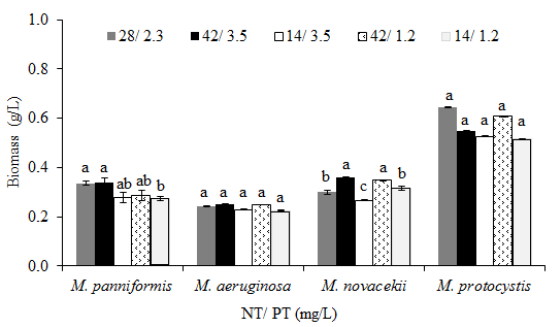
Figure 4 - Maximum biomass and standard deviations (g/L) for the cyanobacteria species cultivated at distinct nitrogen and phosphorous concentrations for 13 days. Significant differences between treatments are represented by different letters (ANOVA One-Way with post hoc Tukey’s LSD, p<0.05).